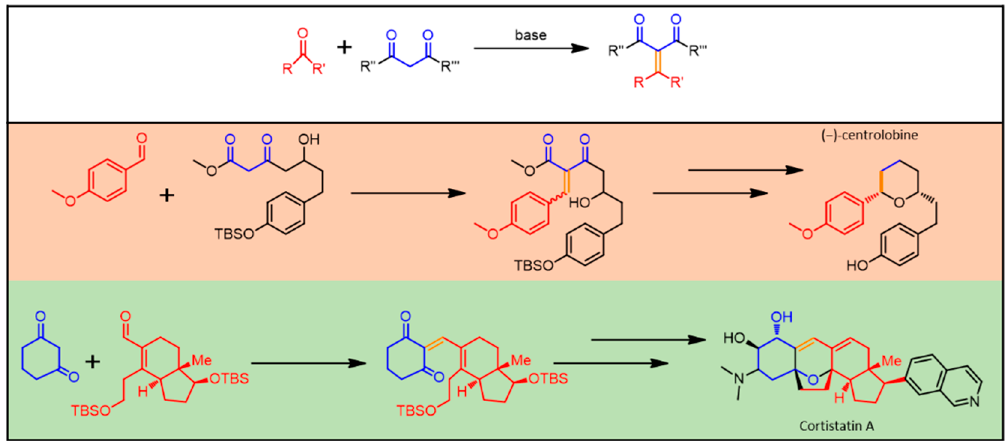
Figure 4. Knoevenagel reaction general scheme. Middle and bottom: examples of some pharmaceutically relevant molecules, whose synthesis involves Knoevenagel condensation. In evidence, the newly formed chemical bond (orange) and the residues belonging to the starting carbonyl (red) and 1,3 ‐ diketo (blue) moieties.